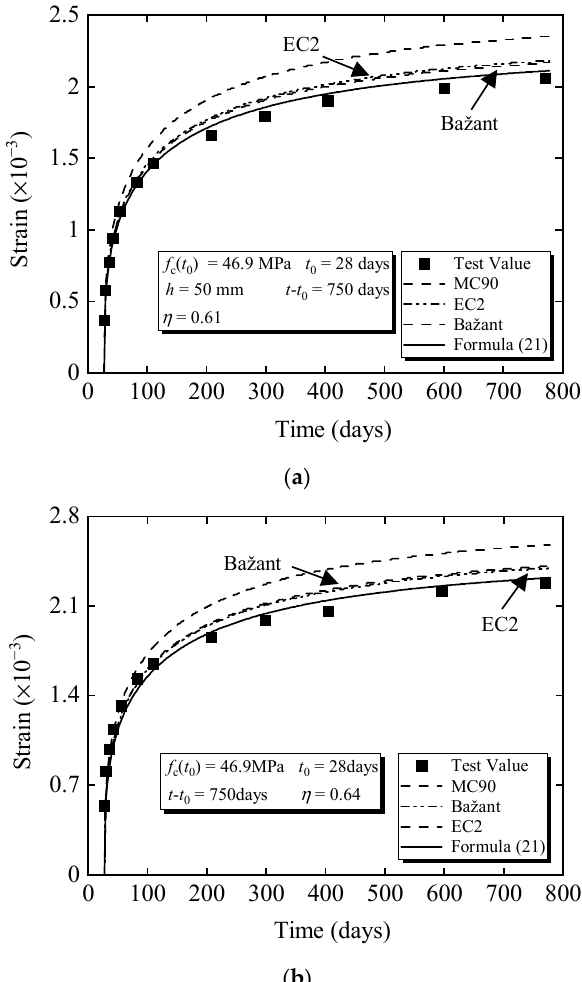
Figure 11. Comparative analysis of test strain: ( a ) strain comparison ( f c = 46.9 MPa and η = 0.61); ( b ) strain comparison ( f c = 46.9 MPa and η =